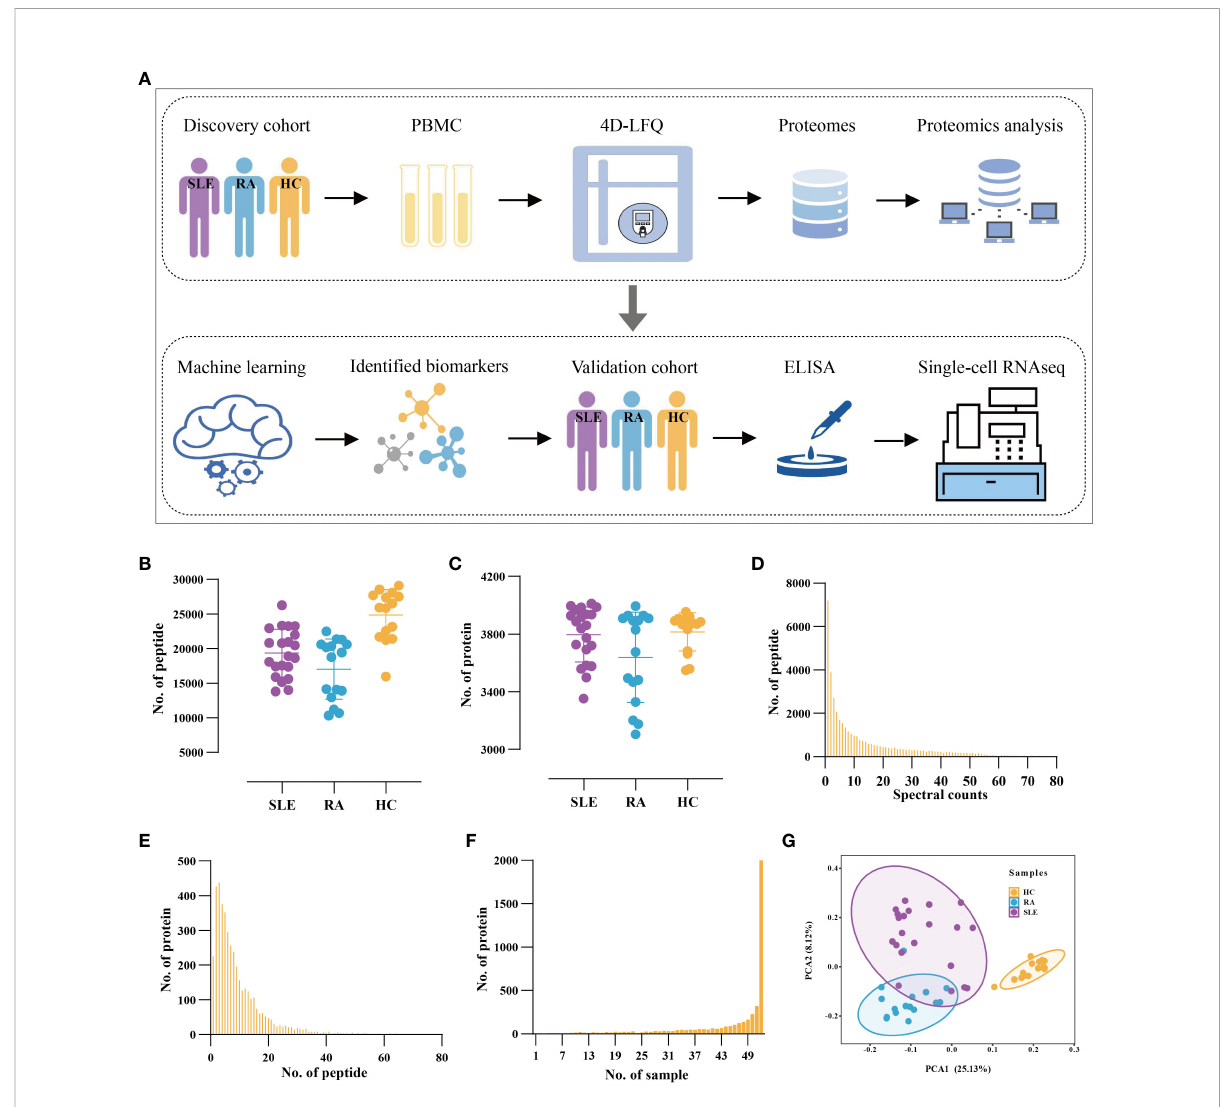
FIGURE 1 Proteomic Pro fi ling of PBMC from SLE and RA patients and Health Volunteers. (A) The work fl ow of the study. All PBMC samples were used for 4D-LFQ proteomics analysis and ELISA analysis. (B, C) The distribution of numbers of quanti fi ed (B) peptides and (C) proteins in the 52 PBMC samples from three groups. Color dots represent multiple independent samples, SLE (n = 21), RA (n = 16), HC (n = 15). (D) The distribution of MS/MS spectral counts of quanti fi ed peptides. (E) The distribution of peptide numbers of quanti fi ed proteins. (F) The distribution of protein numbers in PBMC samples. (G) PCA of proteomic data in HC, SLE, and